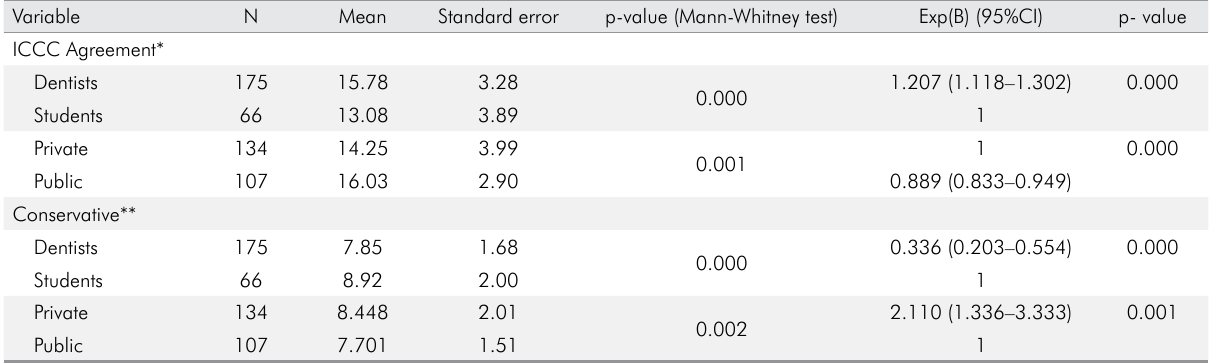
Table 4. Mean values for dentists vs. students and type of institution regarding the “Conservative” and “ICCC Agreement” outcomes. Variable N Mean Standard